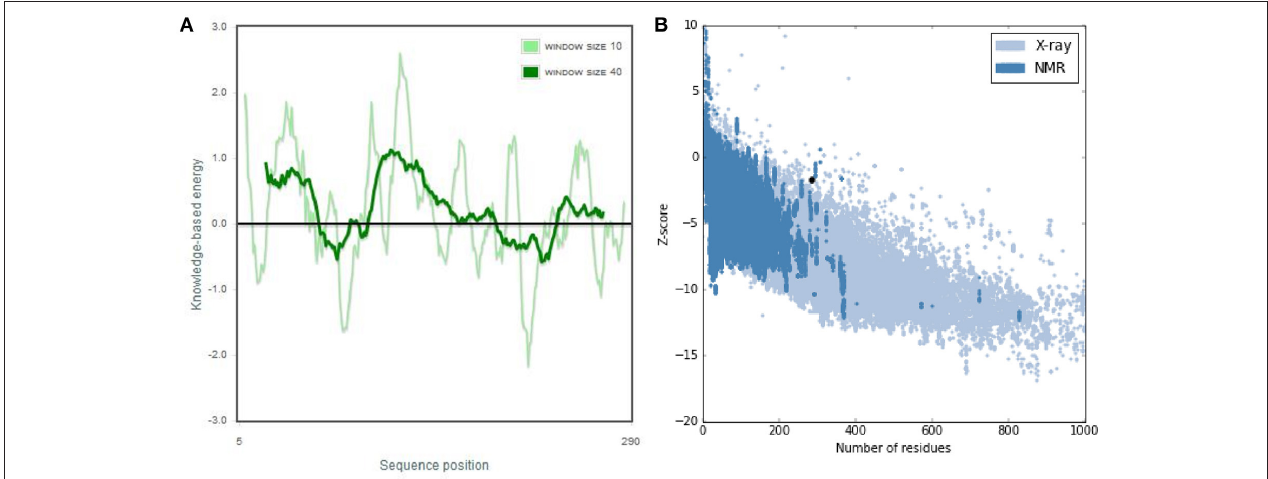
FIGURE 10 | ProSA-web output of Fief shows the local model quality by plotting energies profile of amino acid and bindicating the Z score (or standard score) on a plot based on the entire protein chain in the Protein Data Bank (PDB) determined by X-ray crystallography or Nuclear Magnetic Resonance (NMR) spectroscopy; (A) Overall model quality, (B) Local model quality.